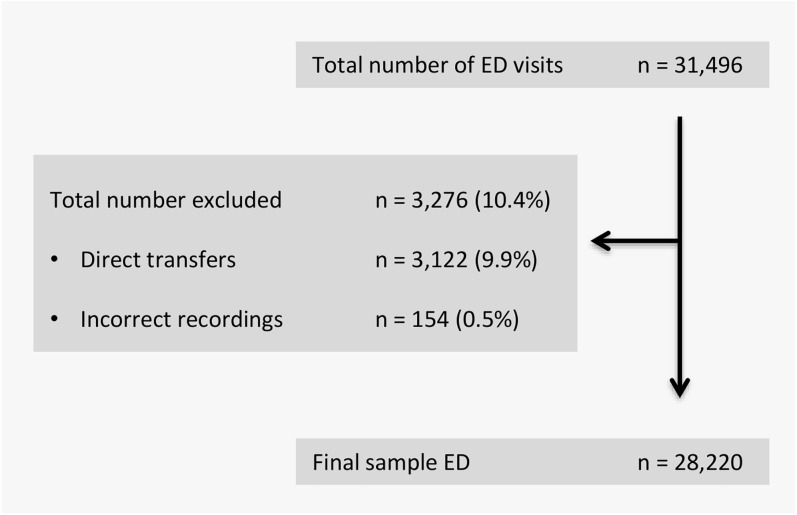
Patient flow diagram.ED = Emergency Department.